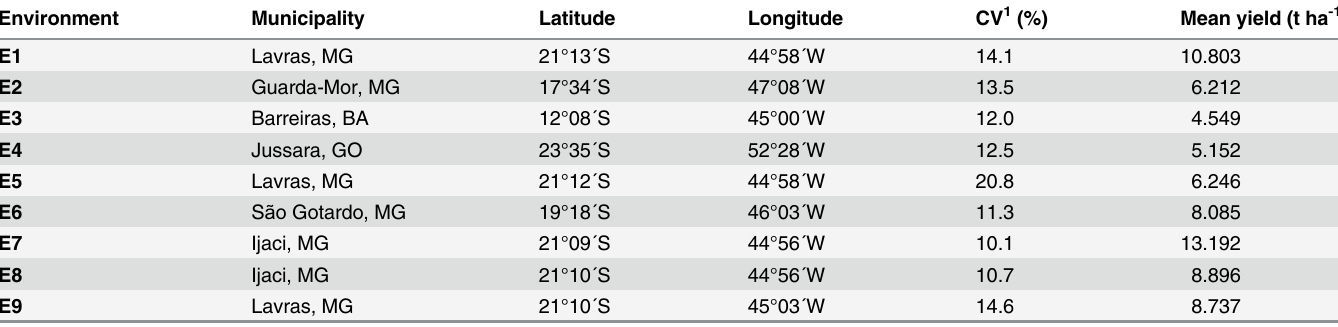
Table 1. Characteristics of the experimental environments.